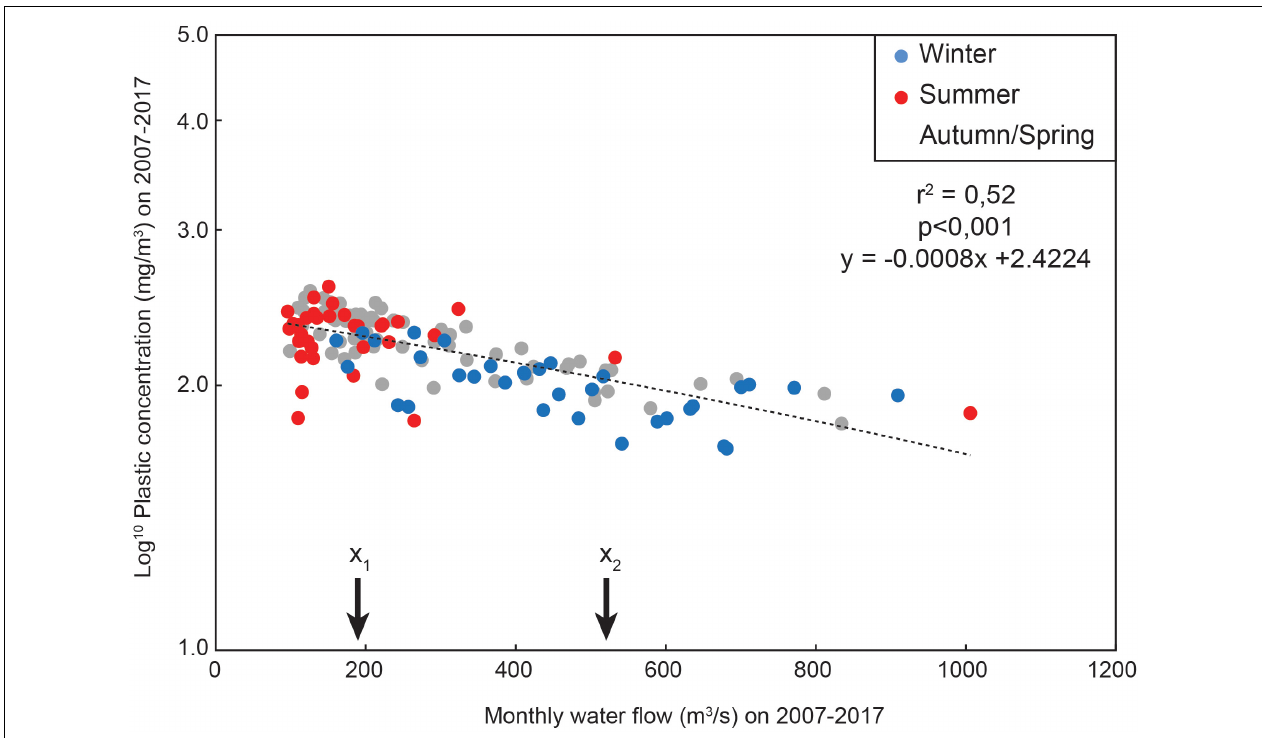
FIGURE 3 | Concentrations (log 10 ) of plastics in the Seine River relative to the monthly mean water flow filtered by 26 floating booms of the SIAAP between 2007 and 2017. Each point corresponds to a monthly mean water flow and associated log 10 concentration of plastics during the same period. Minimum and maximum annual water flow for this period is, respectively, X 1 and X 2 . Concentrations of plastics in mg/m 3 were calculated using (i) the monthly amount of debris collected by booms, (ii) an average plastic rate in debris of 1.4% (Gasperi et al., 2014), and (iii) a ratio between the mean water flow and water flow filtered by boom, i.e., 1/53. The highest mean water flow of 1,006 m 3 /s corresponds to the flood of June